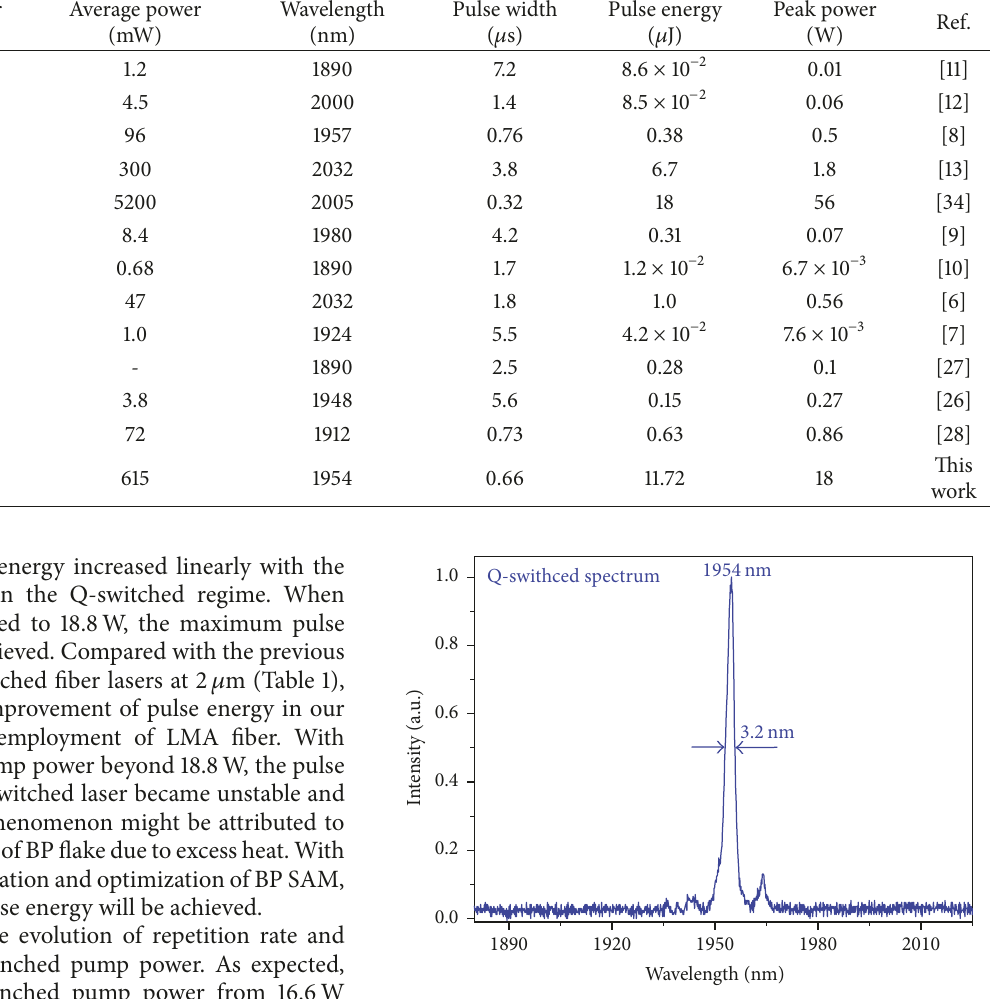
Figure 6: Q-switched pulse